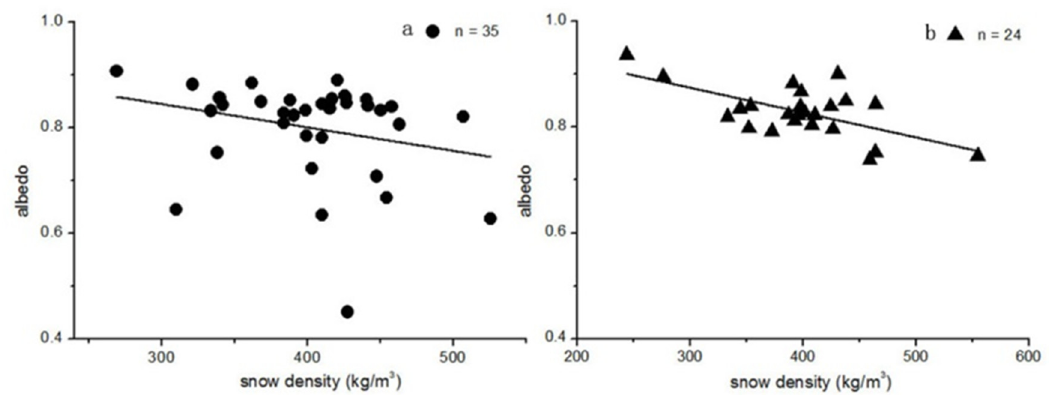
Figure 11. Relationships between snow density and albedo in ( a ) 2013 and ( b ) 2015.